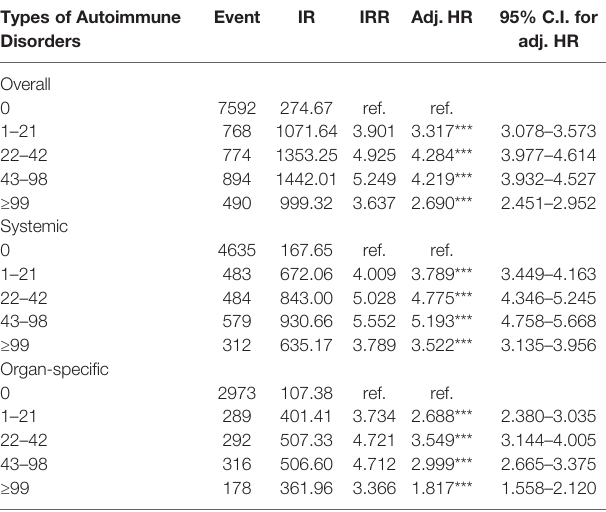
TABLE 3 | The dose response between PPI and autoimmune